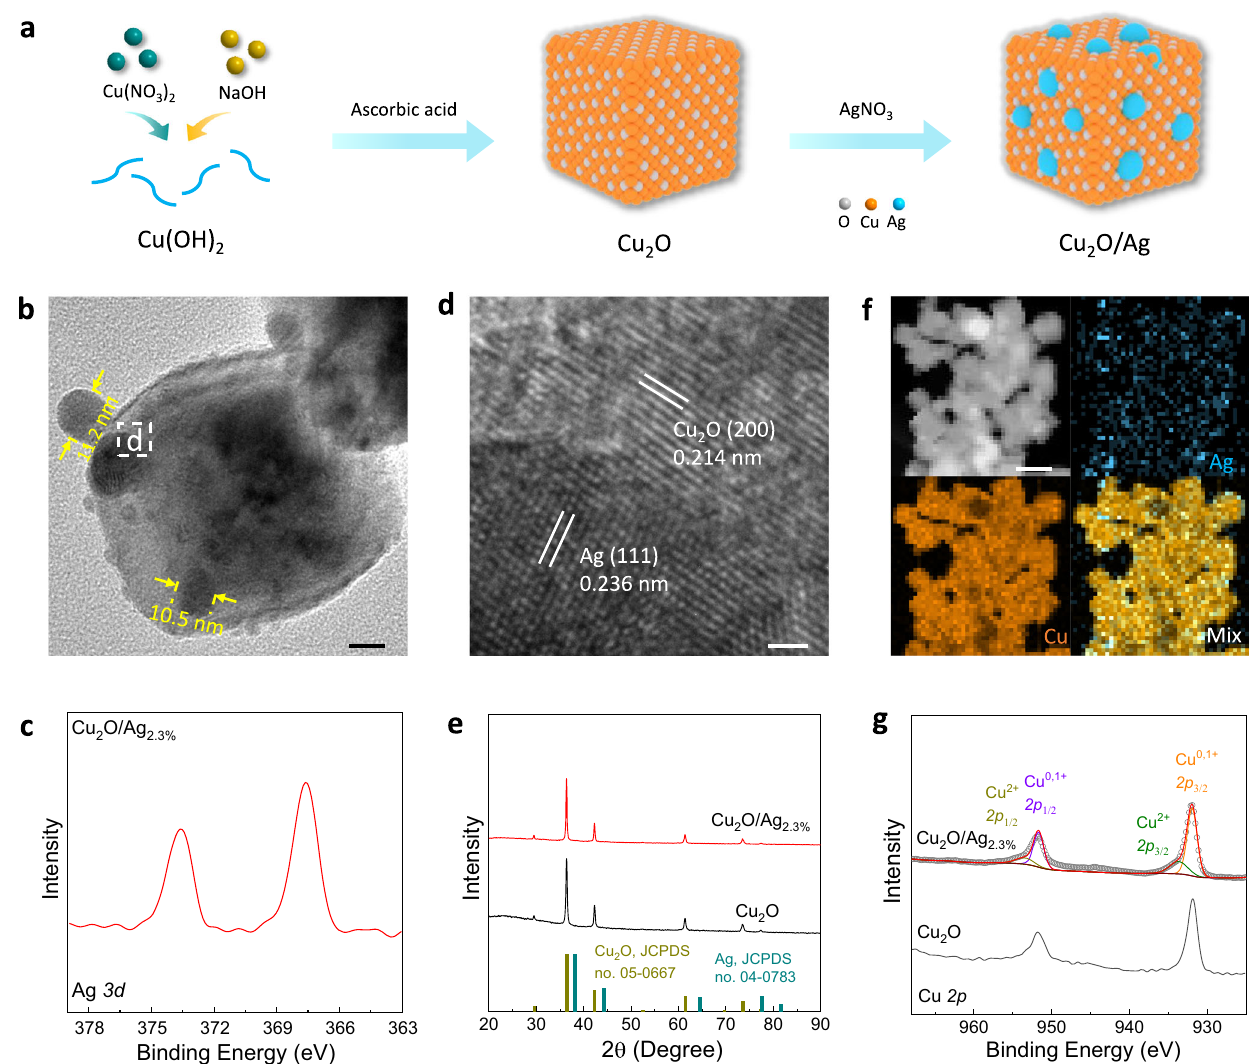
Fig. 1 Structural characterization of Cu 2 O/Ag NCs. a Schematic for preparation of Cu 2 O/Ag NCs. b TEM image, c Ag 3d XPS curve, d HRTEM images and f EDS elemental mapping images of Cu 2 O/Ag 2.3% NCs. e XRD patterns and g Cu 2p XPS curves for Cu 2 O and Cu 2 O/Ag 2.3% NCs. Scale bars, 10 nm in ( b ), 1 nm in ( d ), and 100 nm in ( f ). White-color, orange and azure spheres in the model represent O, Cu, and Ag atoms,